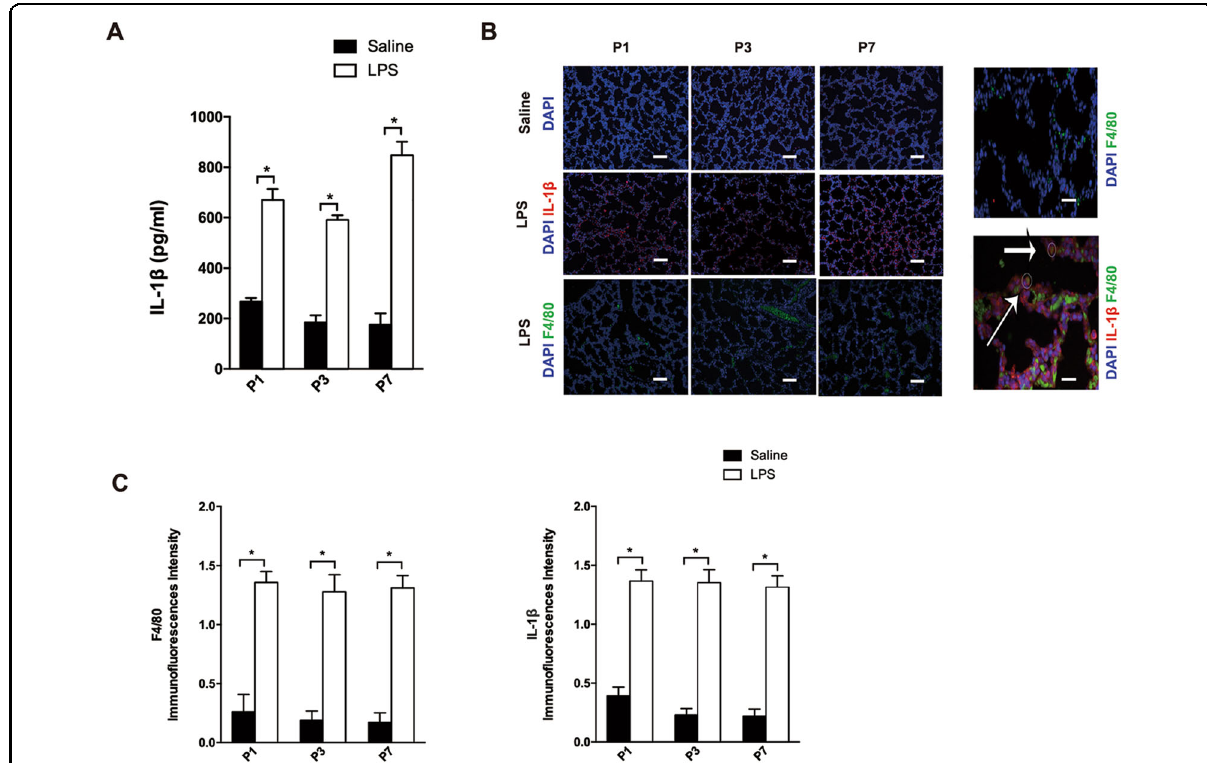
Fig. 2 Macrophages increased in number and were the primary sources of IL-1 β in antenatal LPS – treated rats. A IL-1 β protein levels in rat lung tissues. Data are expressed as mean ± SD ( n = 7), * p < 0.05. B Representative images of lung tissues immunostained for F4/80 and IL-1 β .